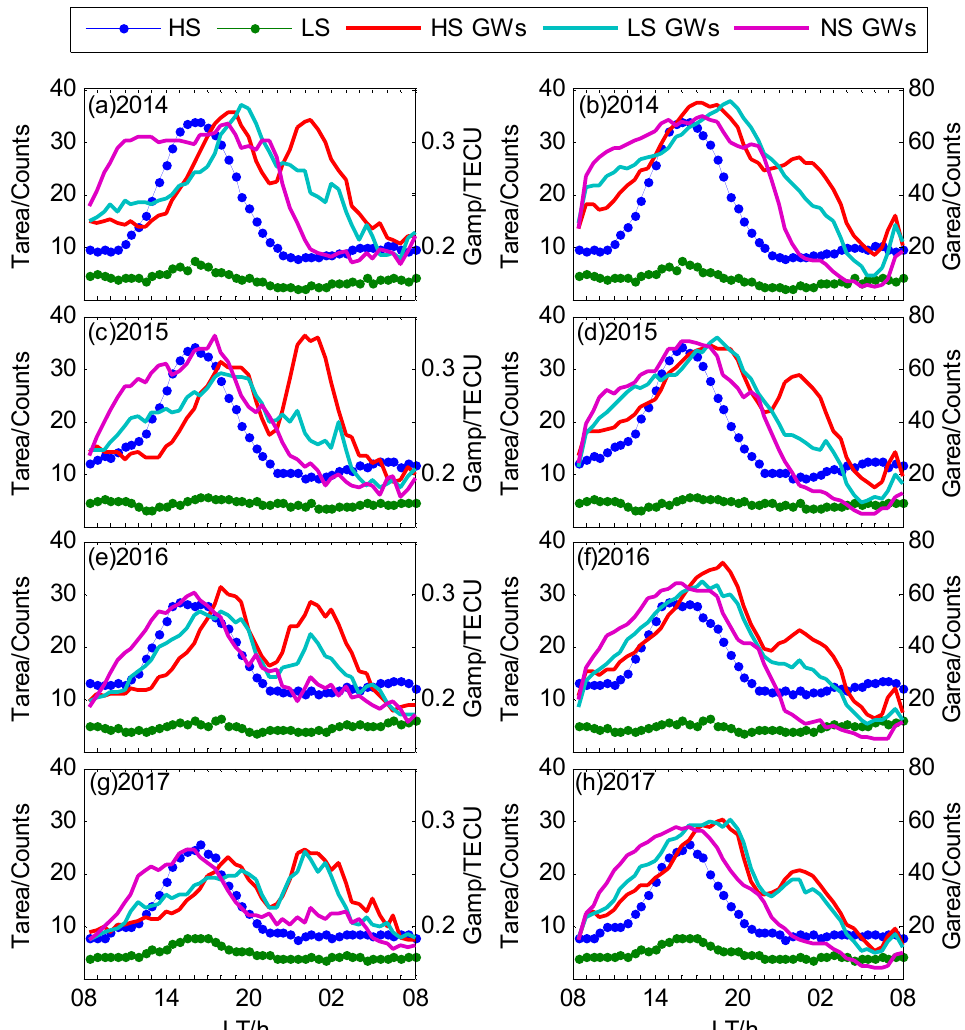
Figure 4. Diurnal averages of thunderstorm activity and ionospheric gravity wave (GW) activity from 2014 to 2017. The line with points represents thunderstorm activity (blue for HS and dark green for LS). The bold line represents ionospheric GW activity (red for HS, cyan for LS, and magenta for NS). ( a ) Thunderstorm coverage versus ionospheric GW amplitude in 2014; ( b ) thunderstorm coverage versus ionospheric GW coverage in 2014; ( c ) thunderstorm coverage versus ionospheric GW amplitude in 2015; ( d ) thunderstorm coverage versus ionospheric GW coverage in 2015; ( e ) thunderstorm coverage versus ionospheric GW amplitude in 2016; ( f ) thunderstorm coverage versus ionospheric GW coverage in 2016; ( g ) thunderstorm coverage versus ionospheric GW amplitude in 2017; ( h ) thunderstorm coverage versus ionospheric GW coverage in 2017.